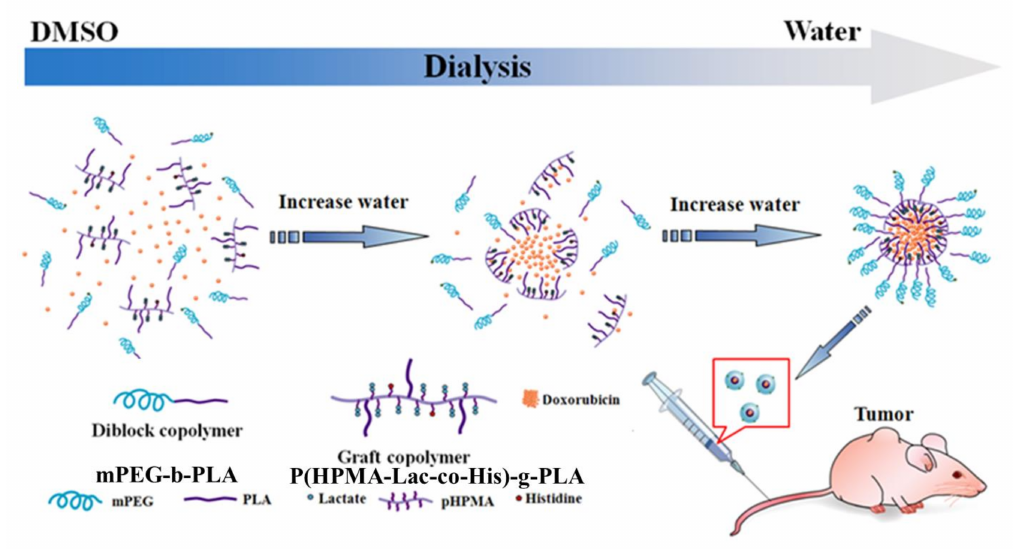
Scheme 1. Schematic representation of the mixed micelle system comprising the graft copolymer P(HPMA-Lac- co -His)- g - PLA and diblock copolymer mPEG- b -PLA. The two polymers were assembled into mixed micelles via dialysis methods. The anticancer reagent, doxorubicin, was encapsulated into the mixed micellar system and the in vivo anticancer therapeutics were